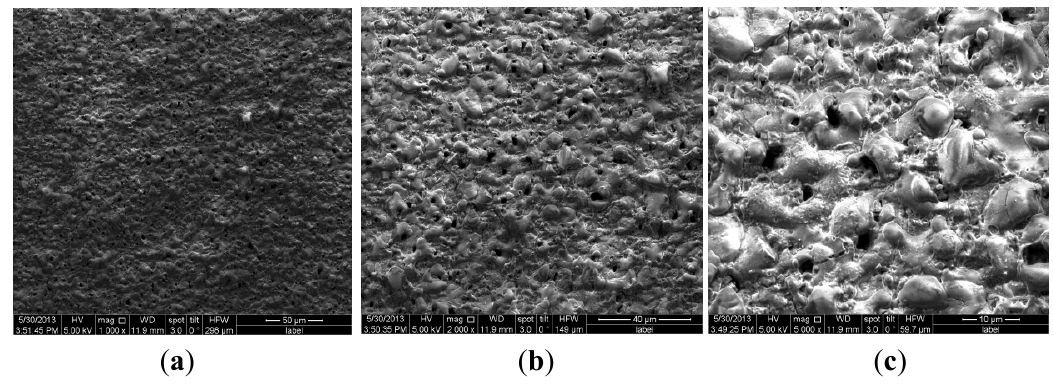
Figure 5. Typical surface morphologies of the hard anodized coating. ( a ) ×100, scale bar